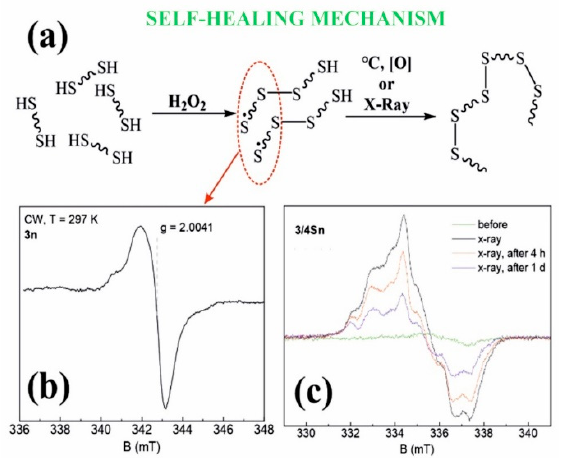
Figure 6. ( a ) Proposed mechanism of self-regeneration; ( b ) Stationary electron paramagnetic reso- nance spectrum of sample 3n (powder) at room temperature in the X-band continuous wave mode (9.6 GHz); ( c ) EPR spectra of 3/4Sn films at T = 15 K before and after X-ray irradiation. No EPR signals in liquid 3/4S samples with different THF concentrations were ob- served, which may indicate the instability of sulfur radicals in these solutions. The heating of 3n powder also did not lead to the formation of new sulfur radicals. The shape of EPR spectrum has a weak (but visible) asymmetry, which indicates the anisotropy of the g- factor arising from the interaction of the electron shell of the radical with the surrounding electric field gradients of neighboring ions. The phase coherence time (T M ) of 578 ns is a rather short value for transverse relaxation compared to other stable radicals [56]. The asymmetry of the spectrum (anisotropy) and the short value of T M (due to nuclear spin diffusion) are associated with the localization of the sulfur radical in the polymer struc- ture. Additionally, samples of 3/4Sn and 3/3Sn in the form of film structures (see SI, Fig- ures S44 and S45) were studied. The EPR spectra show signals from sulfur radicals super- imposed on a broader and structureless line. The formation of this line (underlayer signal)